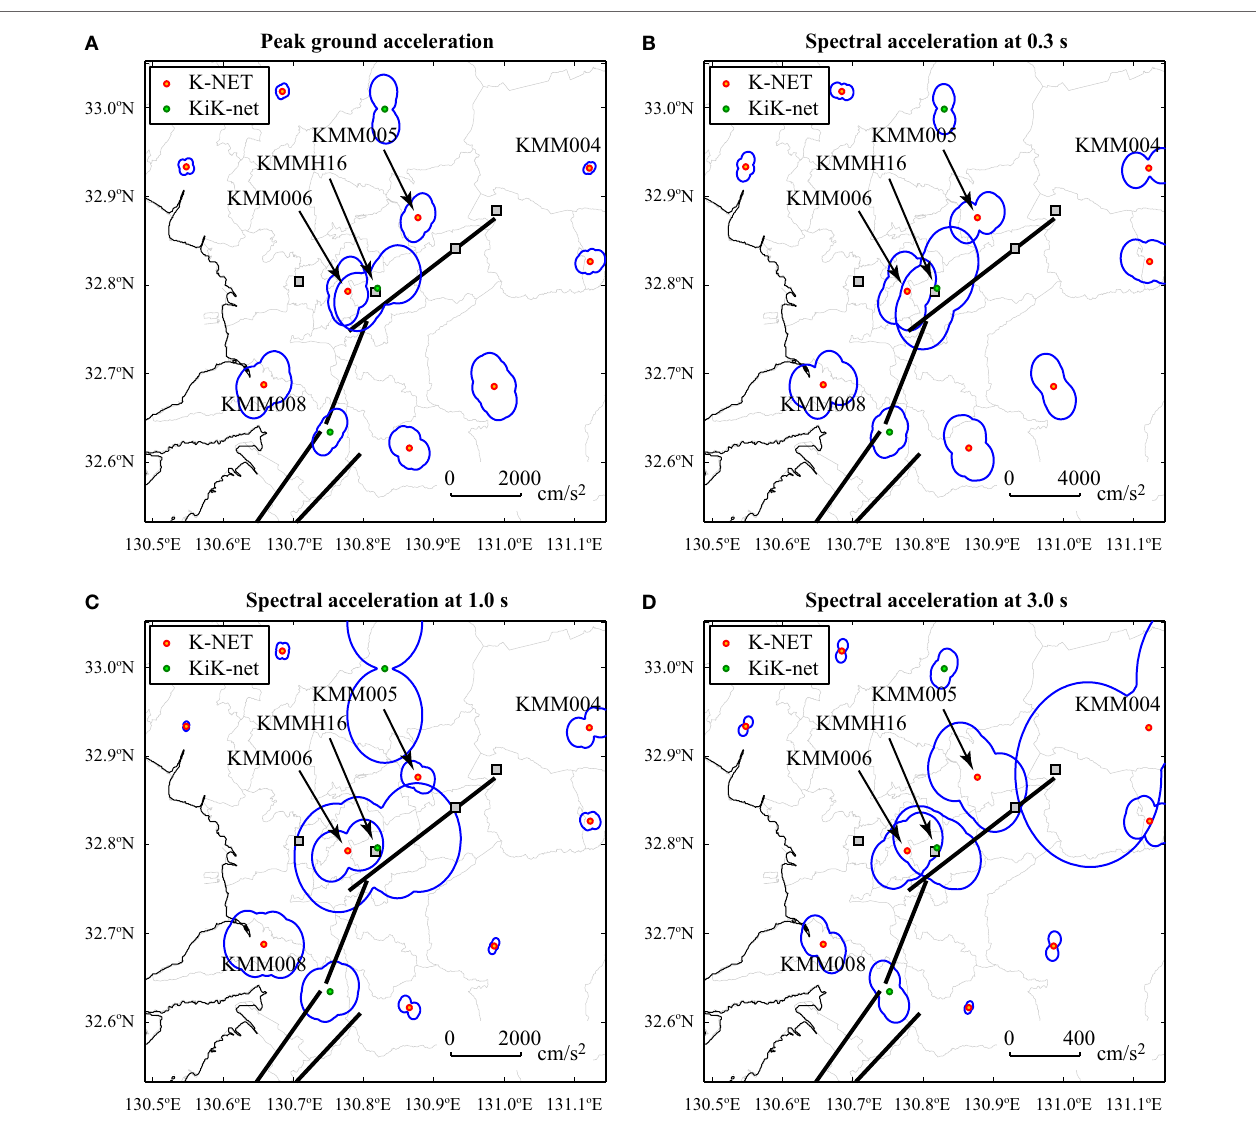
FigUre 8 | (a) Acceleration time-histories for the mainshock at KMM006. (B) Velocity time-histories for the mainshock at KMM006. (c) Acceleration time-histories for the mainshock at KMM008. (D) Velocity time-histories for the mainshock at